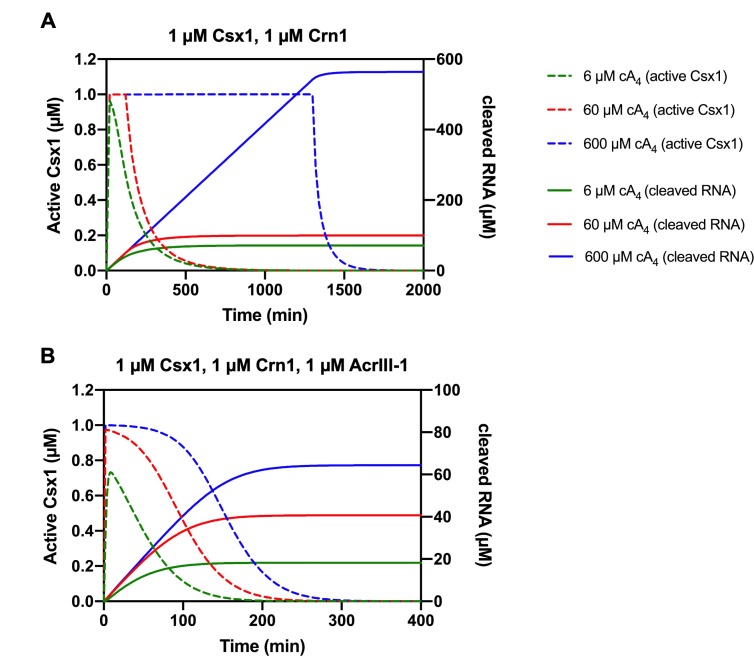
Modelling of the relationship between Csx1 RNA cleavage and deactivation by ring nucleases with varying cA4 concentrations.(A) Active fraction of 1 µM Csx1 (dotted lines, left-hand side y-axis; cA4_Csx1 and cA4_Csx1_RNA) plotted together with cleaved RNA (solid lines, right-hand side axis) in response to varying cA4 concentrations (600 µM, blue; 60 µM, red; 6 µM, green) made by target:Csm complex when 1 µM Crn1 is present. (B) Active fraction of 1 µM Csx1 and cleaved RNA over time in response to varying cA4 concentrations when 1 µM Crn1 and 1 µM AcrIII-1 is present, as colour coded previously.